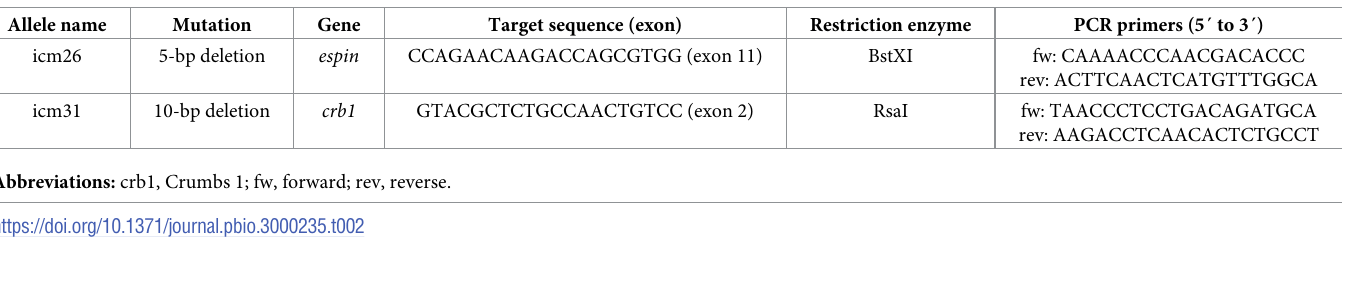
room temperature. When performed below 48 hpf, staging was assessed by counting somites (30 at 24 hpf) according to Kimmel and colleagues [66].